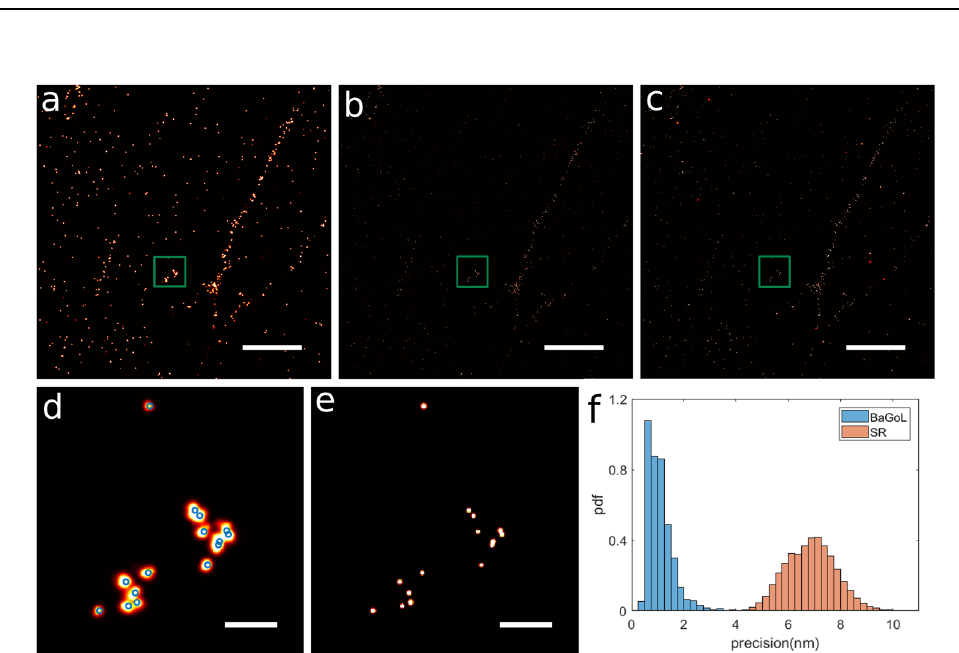
d – f DNA-origami grid with 10nm spacing between docking strands. The shown images were selected from the BaGoL results of 170 similar structures; g – i TUD DNA origami with 5nm spacing between docking strands. The shown images were selected from the BaGoL results of 170 similar structures (see Supplementary Movie 2); j – l MPI DNA origami with 5nm spacing between docking strands. The shownimageswere selected fromthe BaGoL results of four similar structures. The source data is provided within the paper. The scale bars are